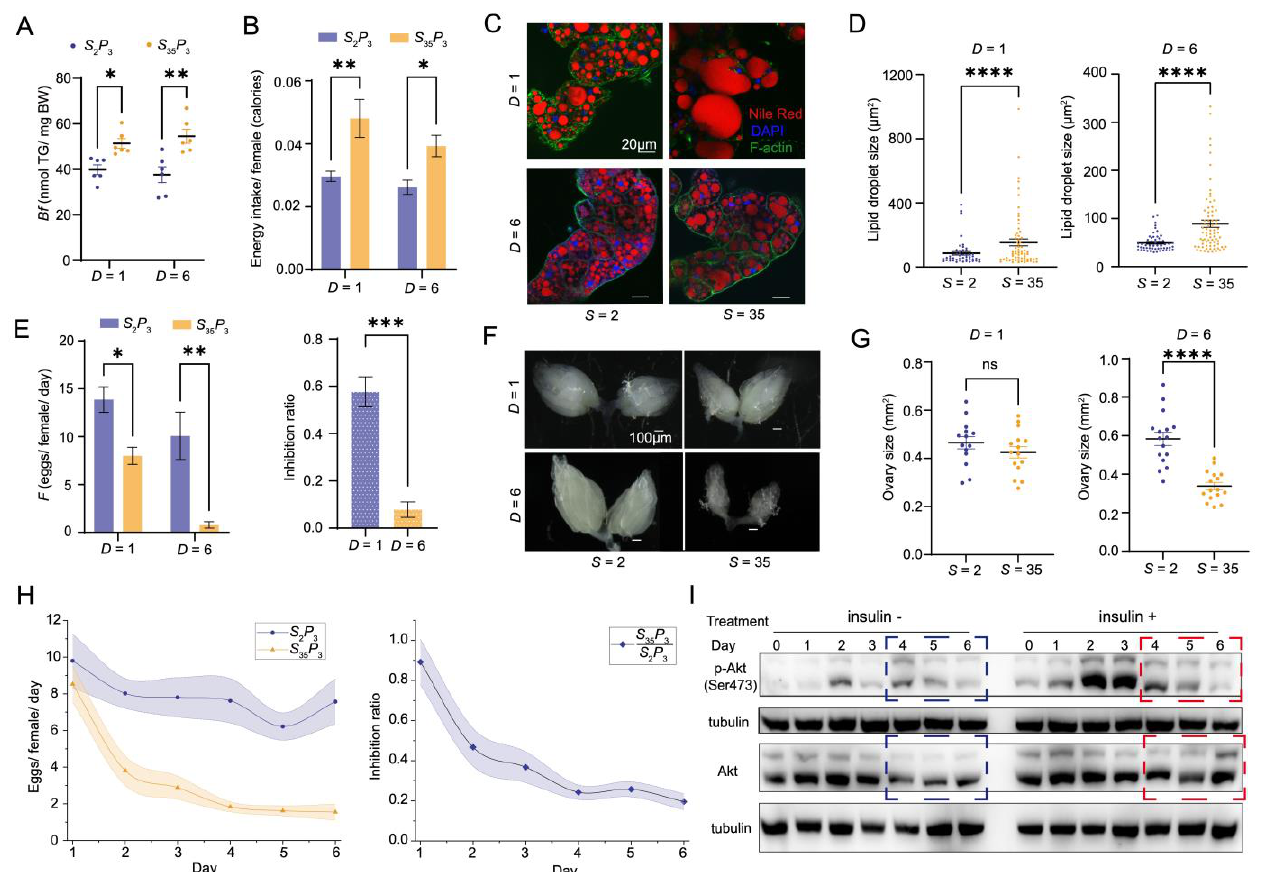
Figure 3. Phenotype verification under the selected treatment conditions. ( A ) Bf measurement under the four indicated conditions (ANOVA), * p < 0.05, ** p < 0.01. ( B ) Calorie intake calculation from feeding quantification with the dye assay under four indicated conditions (ANOVA), * p < 0.05, ** p < 0.01. ( C ) Nile red staining of lipid droplets in the fat body under S 2 P 3 D 1 , S 35 P 3 D 1 , S 2 P 3 D 6 , S 35 P 3 D 6 . F-actin stained with phalloidin was in green, nucleus stained with DAPI was in blue. Scale bars: 20 µ m. ( D ) Measurements and statistical analysis of lipid droplet size under the four indicated conditions ( t -test), **** p < 10 − 4 . ( E ) F measurement under four conditions (ANOVA). The inhibition ratio of high sucrose on F was calculated by the number of eggs produced under S 35 P 3 divided by that under S 2 P 3 ( t -test), * p < 0.05, ** p < 0.01, *** p < 10 − 3 . ( F ) Comparison of whole ovarian morphology under four conditions. Scale bars: 100 µ m. ( G ) Measurement and statistical analysis of ovarian size under four conditions ( t -test), **** p < 10 − 4 . ( H ) Continued egg production from day 1 to day 6 on the indicated diet. The inhibition ratio as a function of treatment time under high sucrose diet. See Materials and Methods for further details. ( I ) Shown are Western blotting results detecting p-Akt, Akt, and tubulin of the ovary ( D = 0 to D = 6), with or without the addition of human insulin to the dissected ovaries. Insulin sensitivity was calculated as the ratio of detected protein levels, p-Akt/Akt. Protein levels were normalized to that of